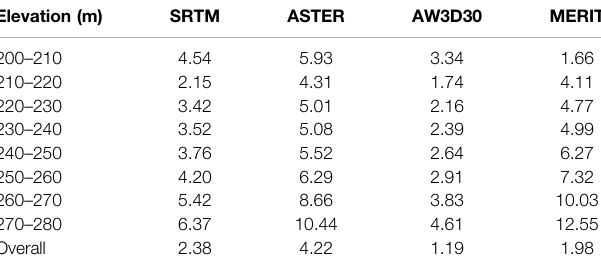
TABLE 2 | RMSE for each DEM at 10-m elevation intervals of the LiDAR